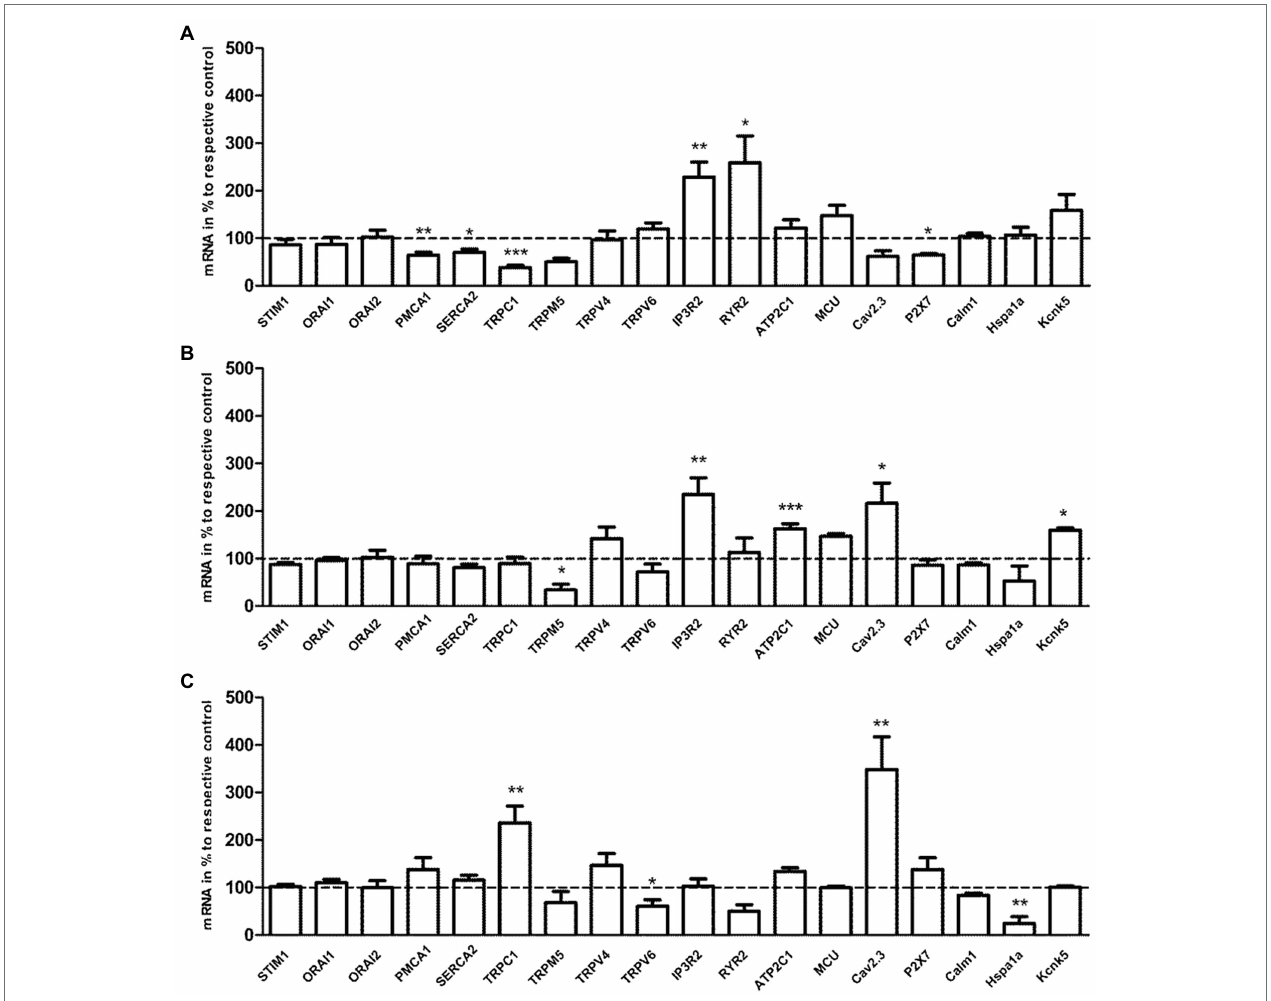
FIGURE 5 | The effects of acute exercise in transcriptional level of Ca 2+ -regulating genes of murine splenic T lymphocytes. (A) mRNA expression of the E3 group vs. the control. (B) mRNA expression of the E24 group vs. the control. (C) mRNA expression of the E24 group vs. the E3 group. The transcription level of Ca 2+ - regulating genes was normalized to the housekeeping gene, β -actin mRNA. Note that columns and error bars represent (mRNA in % to respective control ±SEM); * p < 0.05, ** p < 0.01, *** p < 0.001 ( n =